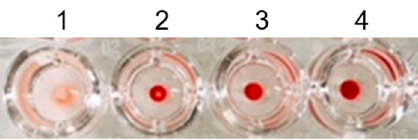
Figure 5. The e ff ect of dilution ratio of blood on red blood cell (RBC) agglutination induced by PBA-Ins. Well 1 (blood 1 / 800), well 2 (blood 1 / 400), well 3 (blood 1 / 320), and well 4 (blood 1 / 160). All wells contained 0.17 mM